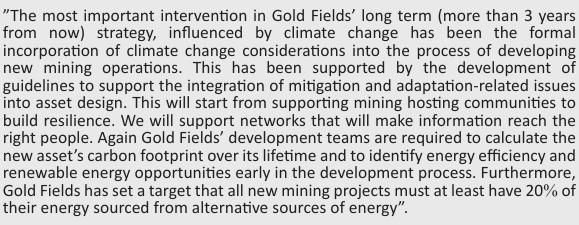
BOX 1: Goldfields on climate change and information